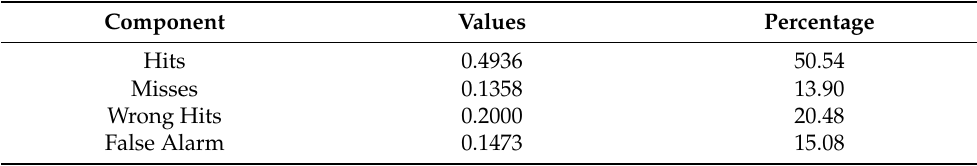
Table 14. The figure of merit (FOM) component LULC prediction.